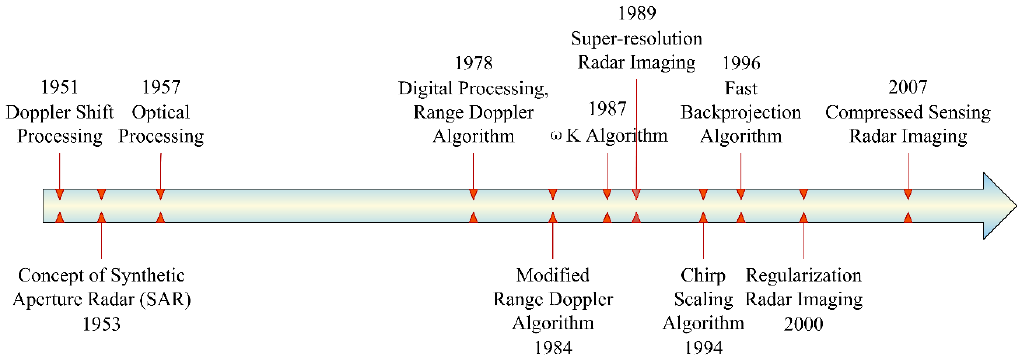
Figure 1. Developmental history of radar imaging methods.